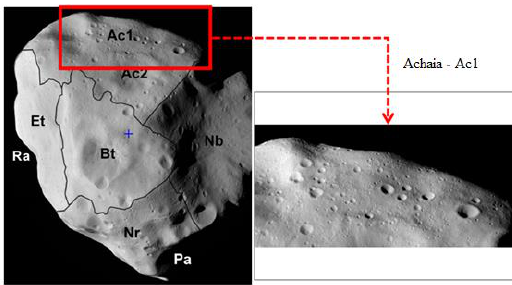
Figure 1. Regions identified on the asteroid Lutetia (21) surface with the specification of the area of interest (MPS/UPD/LAM/IAA/RSSD/INTA/UPM/DASP/IDA)